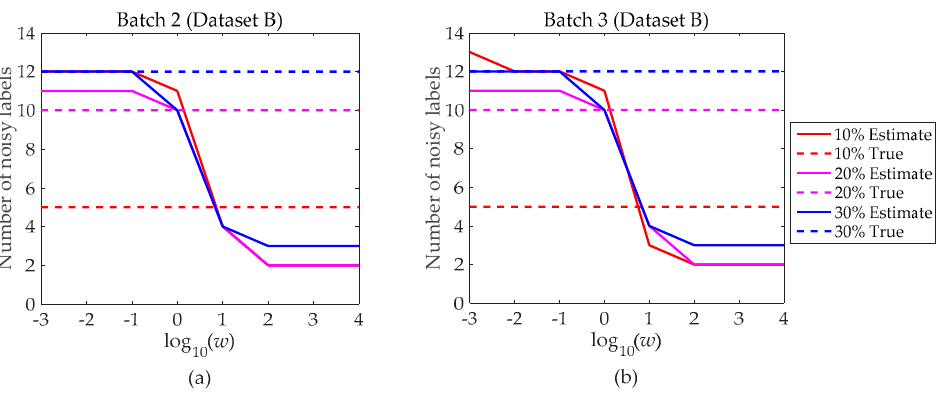
Figure 8. Estimated number of noisy labels with w (dataset A). ( a ) Noisy number of batch 2, ( b ) noisy number of batch 3, ( c ) noisy number of batch 4&5, ( d ) noisy number of batch 6, ( e ) noisy number of batch 7, ( f ) noisy number of batch 8, ( g ) noisy number of batch 9; ( h ) noisy number of batch 10.